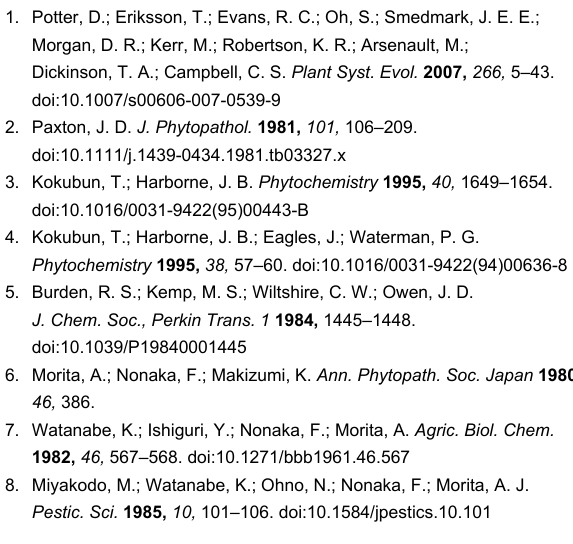
The simultaneous formation of biphenyls and dibenzofurans in M. domestica [3,9-12], P. communis [3,12,16,17], and S.